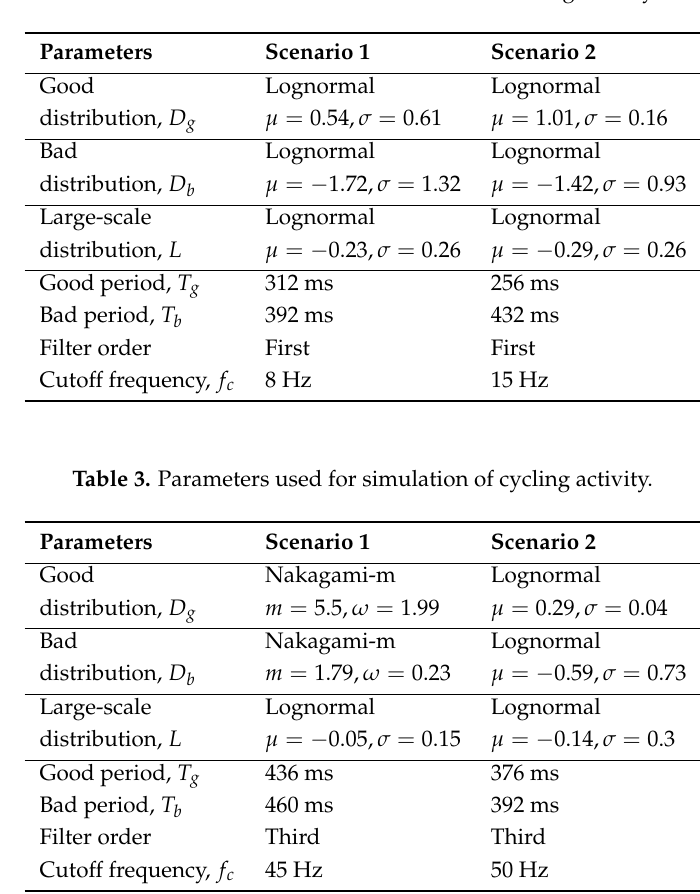
Table 2. Parameters used for simulation of running activity.